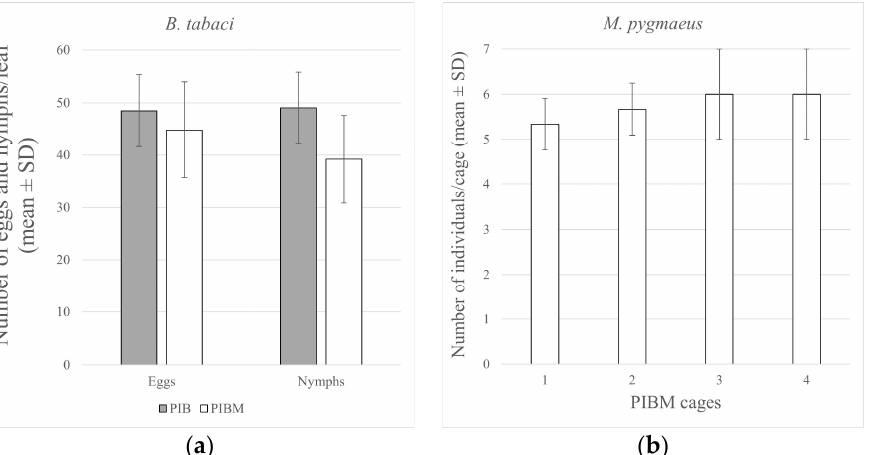
Figure 1. Mean number (±SE) of ( a ) B. tabaci eggs laid and nymphs fixed on the lower surface of each of the three selected leaves per plant under both PIB and PIBM conditions and ( b ) M. pygmaeus specimens per PIBM cage.